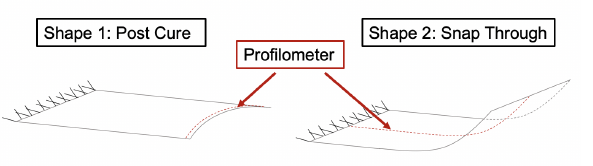
Figure 6. Schematic showing where the post cure curvature and snap through curvature were measured with the